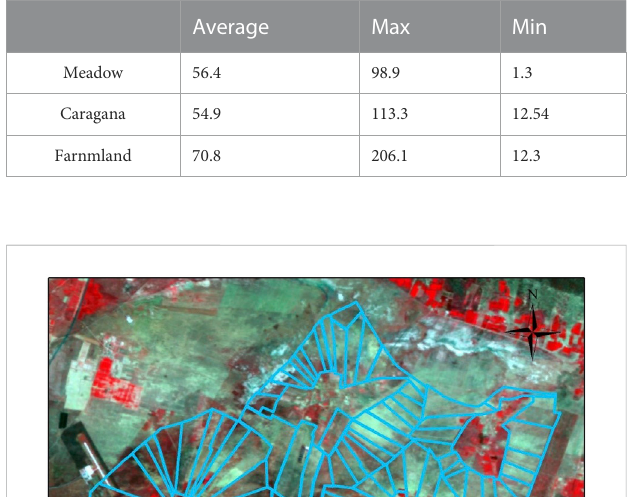
TABLE 2 Above-ground biomass data summary/(g/m 2 ).